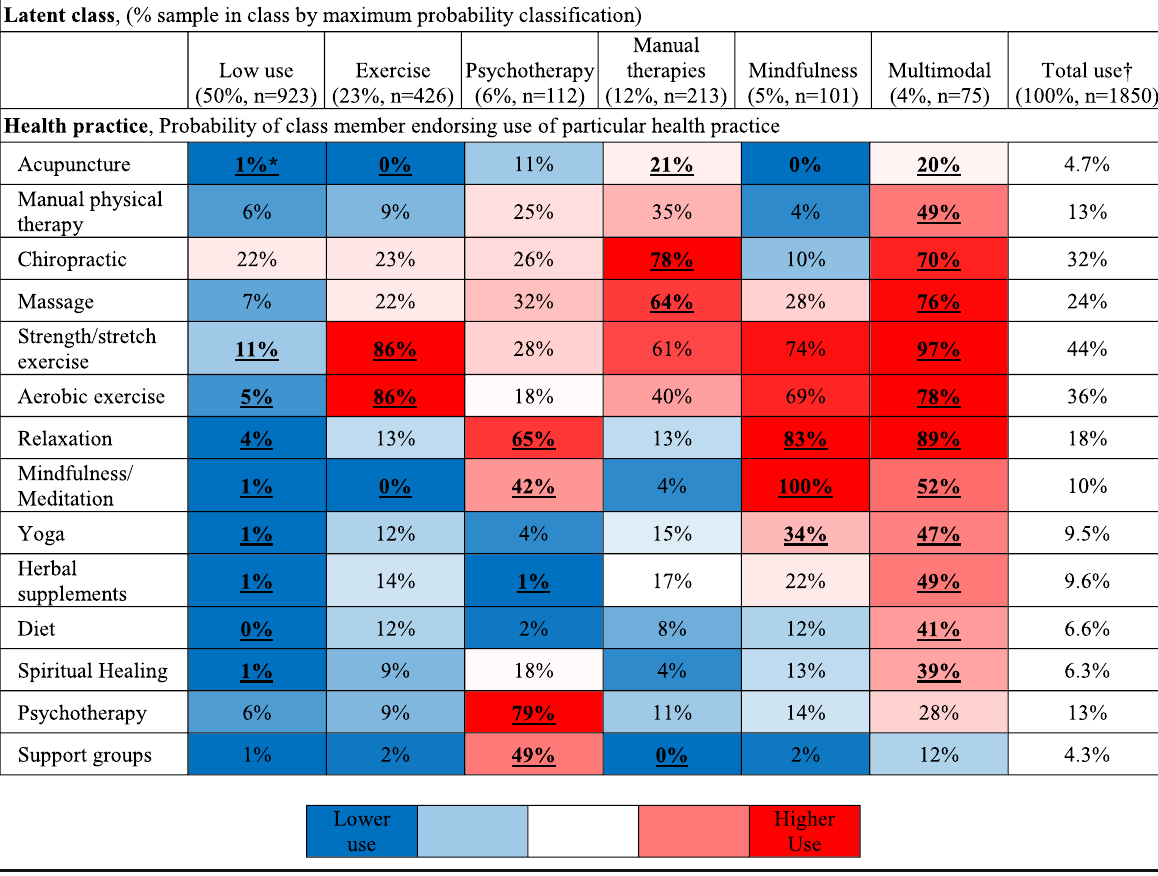
Table 3 Probability of use of Health Practices Inventory approaches within latent classes of 1850 Minnesota National Guard Veterans who participated in a mailed survey conducted from October 2015 to September